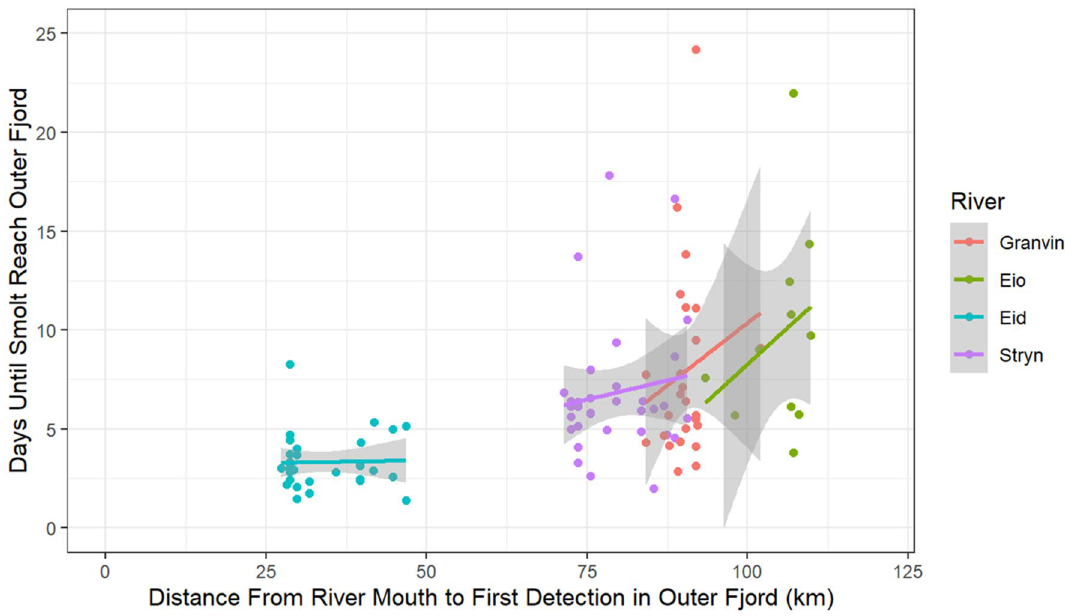
fjord is represented by zone D. Colored lines represent the results of river-specific linear regressions along with associated 95% confidence